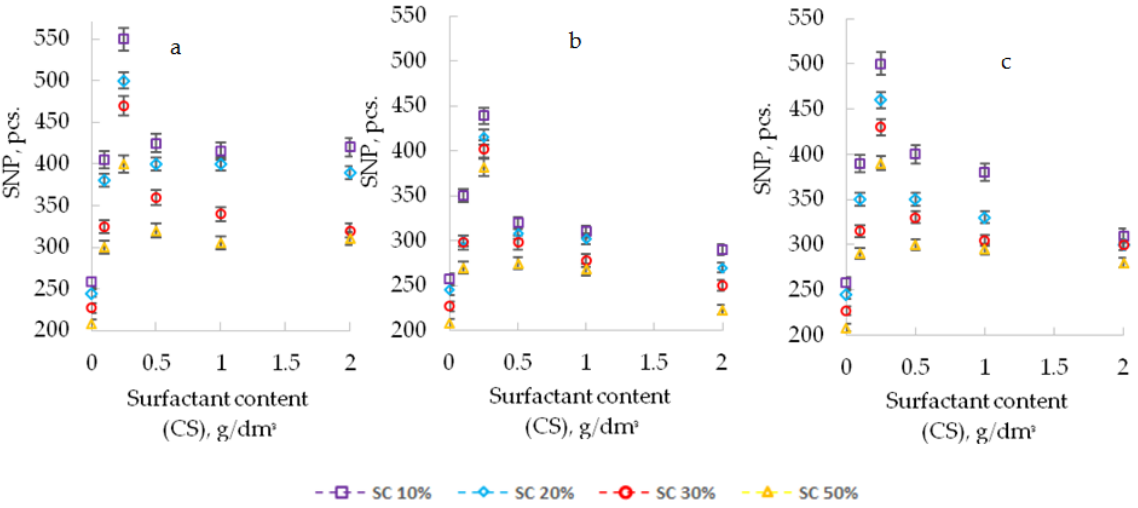
Polymers 2021 , 13 , x FOR PEER REVIEW Figure 2. Influence of the type and content of surfactants (CS) on SNP at different SC (10–50%); ( a ), PEPA; ( b ), AS-1; and ( c ), Telaz. Figure 3 shows photos of suspensions obtained by computer-optical microscopy, with different content of additives.